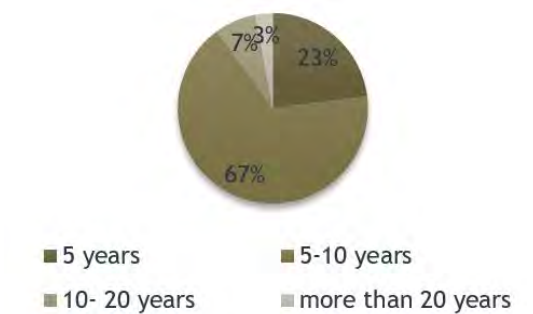
Figure 8. Period of residence